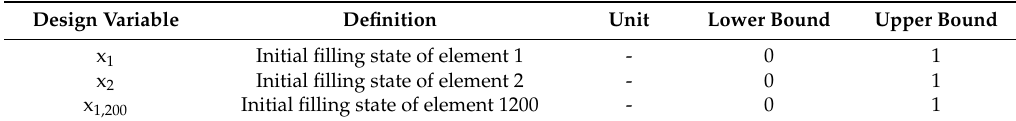
Table 4. Description of the design variables.